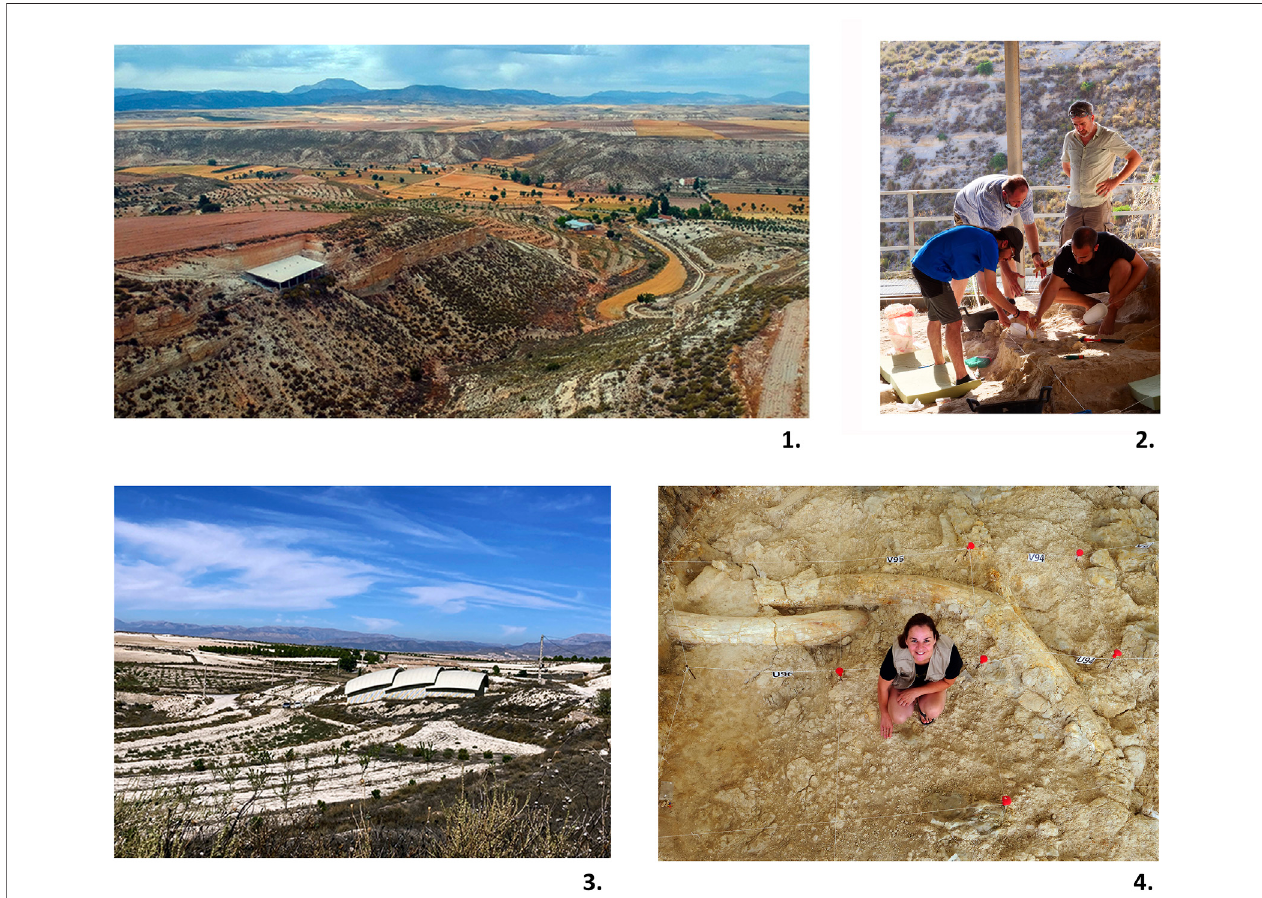
FIGURE 2 | General views of the Oldowan sites of Barranco León and Fuente Nueva 3 sites: 1) View of the Barranco León site on the edge of the ravine (Photo: Chmiel F.L.); 2) View ofexcavationsat the Barranco León site in 2020 (Photo: J. Cámara);3) View of the Fuente Nueva 3 site (Photo D. Barsky); View ofthe Mammuthus meridionalis tusks in situ in level 5 of the Fuente Nueva 3 site (Photo: J. Cámara).